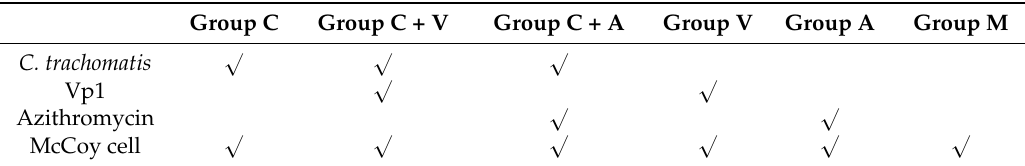
Table 1. Design groups for